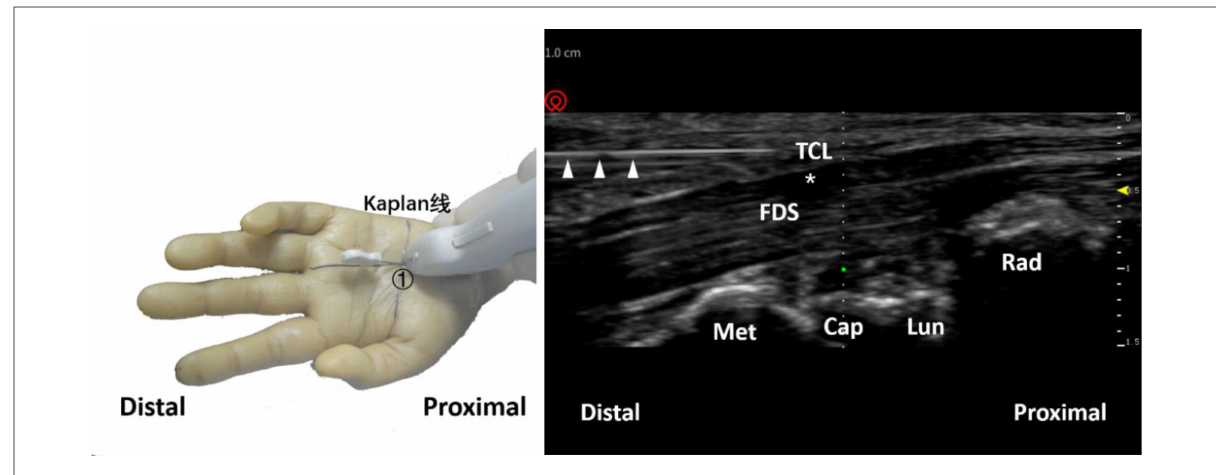
FIGURE 4 Schematic diagram of probe placement (left) and ultrasound-guided needle knife release diagram (right). The triangle refers to the needle knife position. The asterisk refers to the median nerve. ① , needle entry point 1; TCL, transverse carpal ligament; FDS, fl exor digitorum super fi cialis; Met, metacarpal bone; Cap, capitate bone; Lun, lunate bone; Rad, radius.